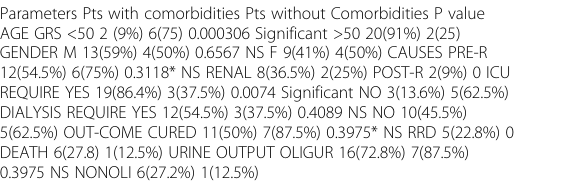
Parameters Pts with comorbidities Pts without Comorbidities P value AGE GRS <50 2 (9%) 6(75) 0.000306 Significant >50 20(91%)